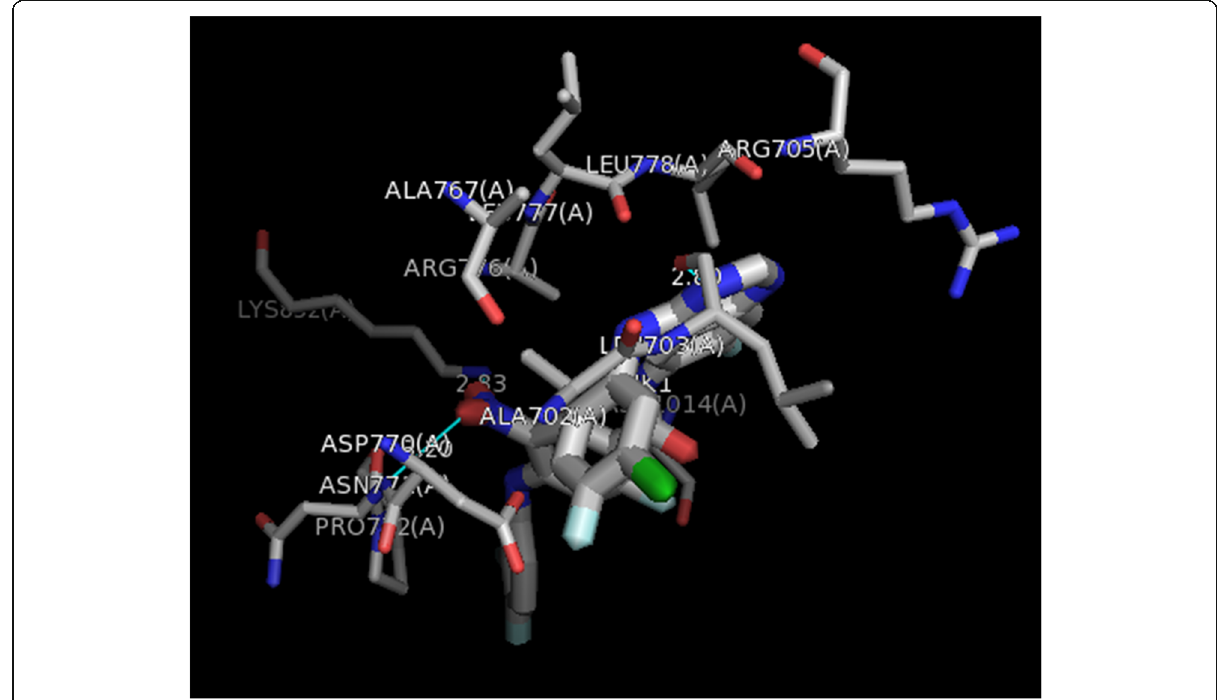
Fig. 8 Siteview 3D structure of A SDD4 receptor and B SCD4 receptor using